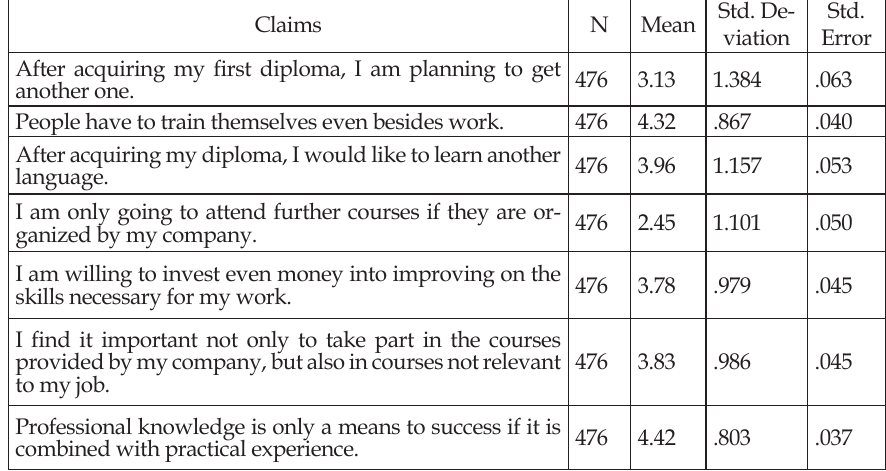
Table 3. Chart 3: Opinions Regarding Post-University Professional Knowledge Development. Claims N Mean